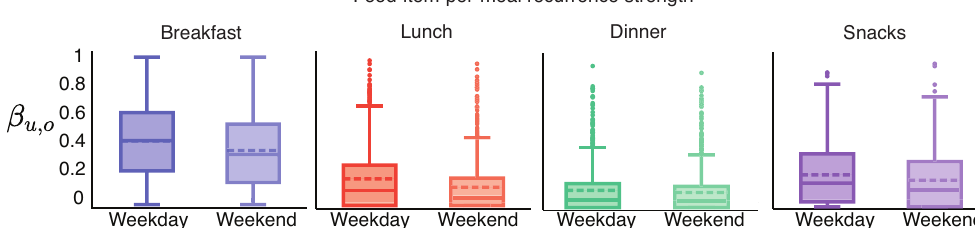
Figure 5. Differences in recurrence strength tuple between weekdays and weekends for breakfast, lunch, dinner, and snacks. The number of individuals in every box plot is